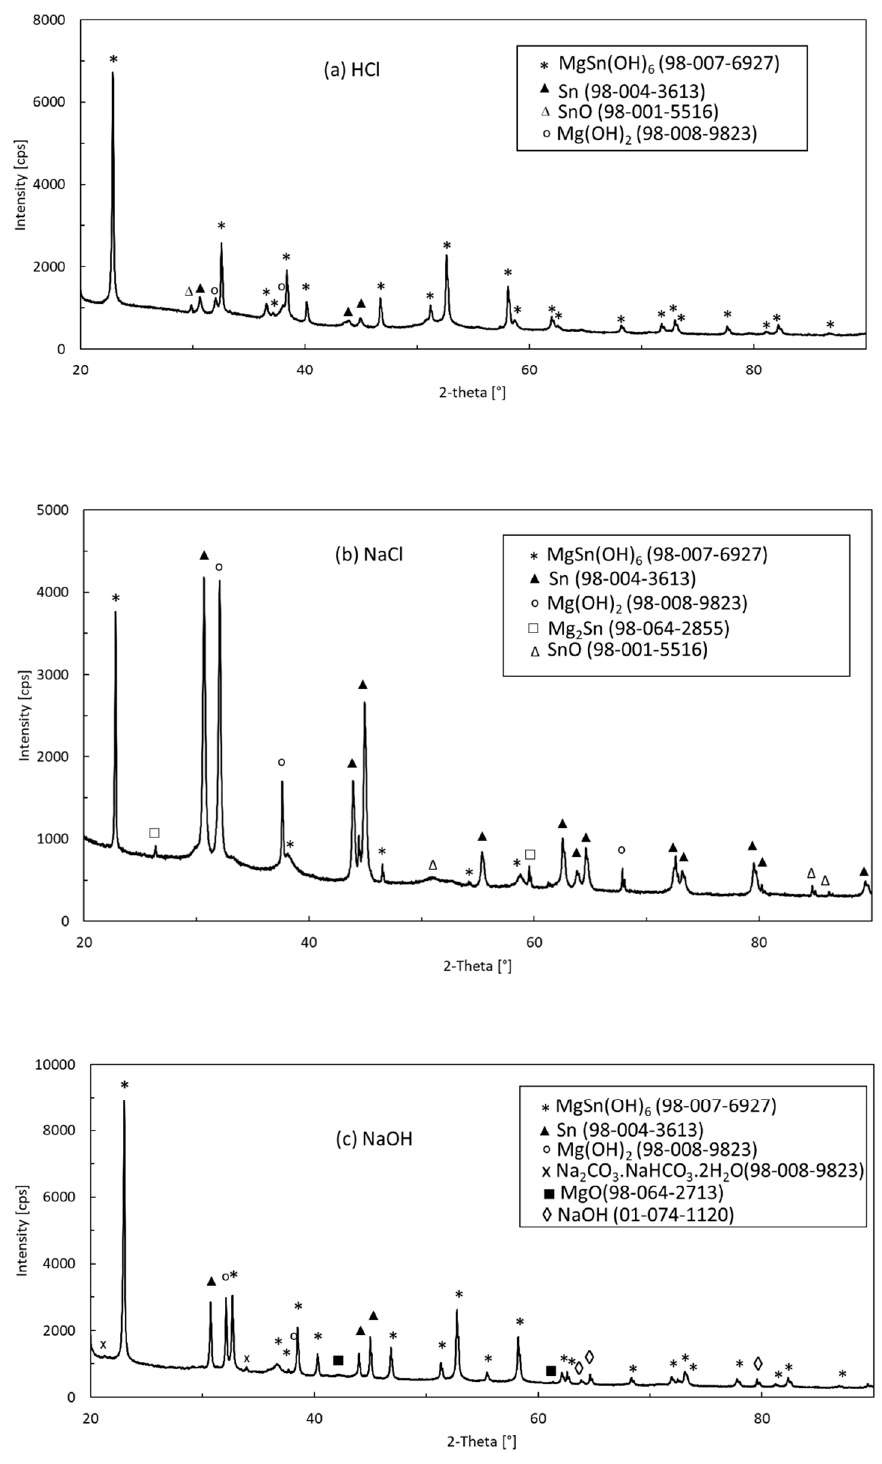
Figure 13. XRD patterns of the corrosion products of the Mg 2 Sn alloy formed in HCl ( a ), NaCl ( b ) and NaOH ( c ).